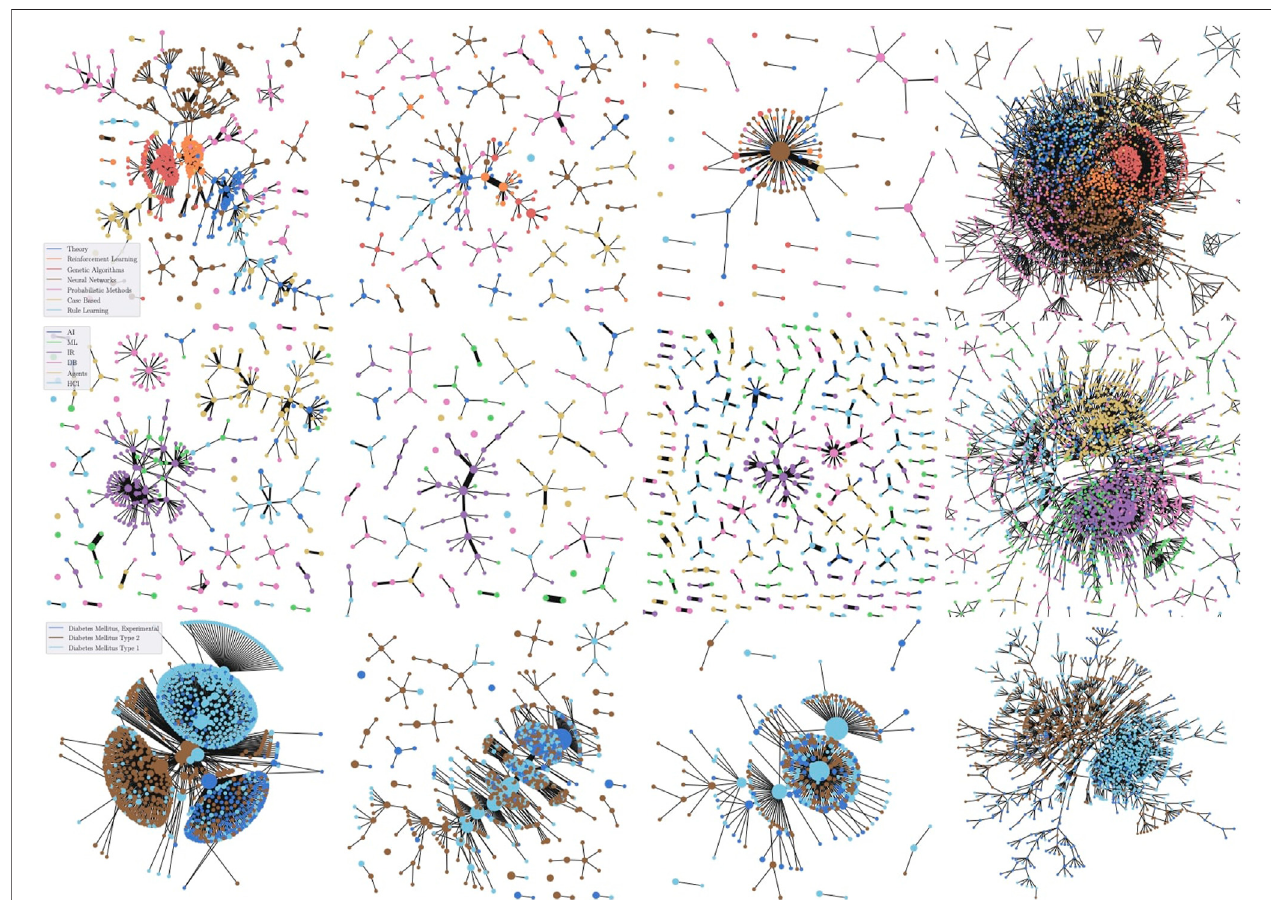
FIGURE 4 | Qualitative comparison between SDGM ( fi rst column), Mapper with an RBF graph density function (Hajij et al., 2018) (second), and Mapper with a PageRank function (Hajij et al., 2018) (third). The Graphviz visualization of the graph cores (fourth column) are added for reference. The rows show plots for Cora, CiteSeer, and PubMed, respectively. The graphs are colored based on the most frequent class in each cluster to aid the comparison. SDGM with unsupervised lens implicitlymakesalldatasetclassesappearinthevisualizationmoreclearlyseparated.Thisdoesnothappeninthebaselinevisualisations,whichmainlyfocusonthe class with the highest number of nodes from each